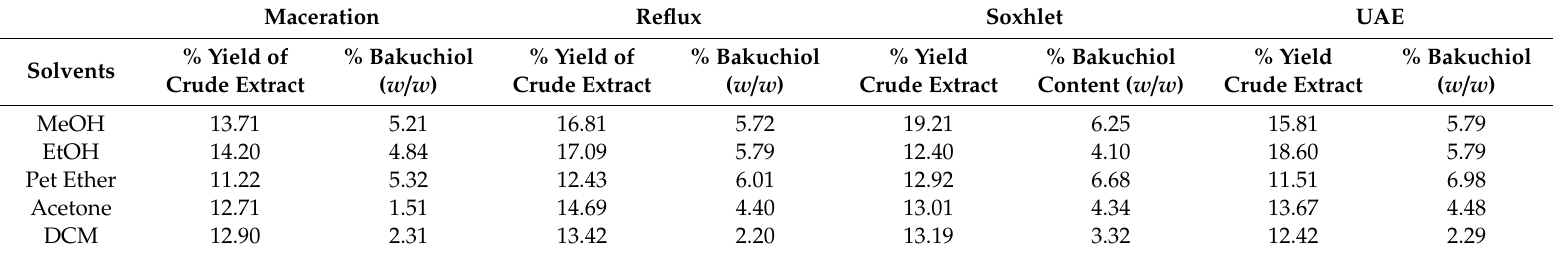
Table 1. Bakuchiol content in di ff erent extracts using di ff erent extraction techniques.